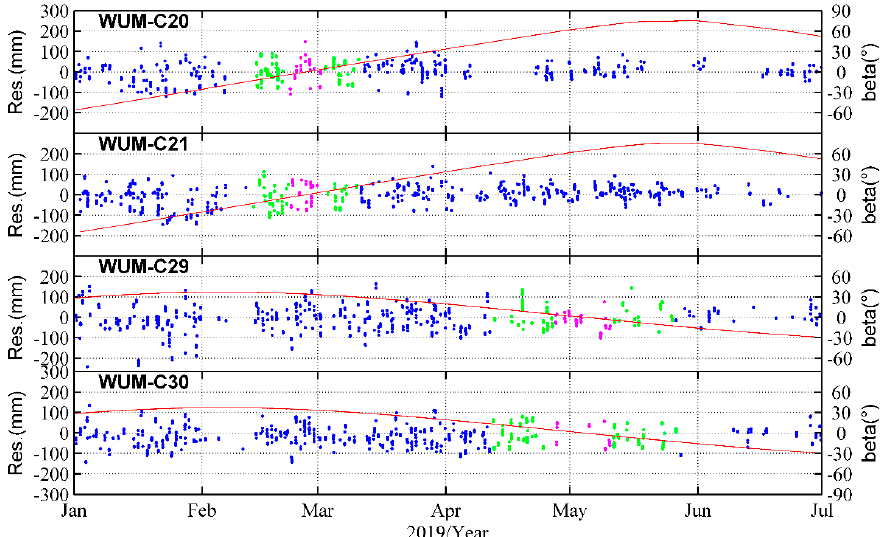
Figure 5. The SLR validation time series for BDS-3 satellites derived from WUM in the half-year time series since 2019. The definition of different colour dots and the red line are the same as in Figure 4.